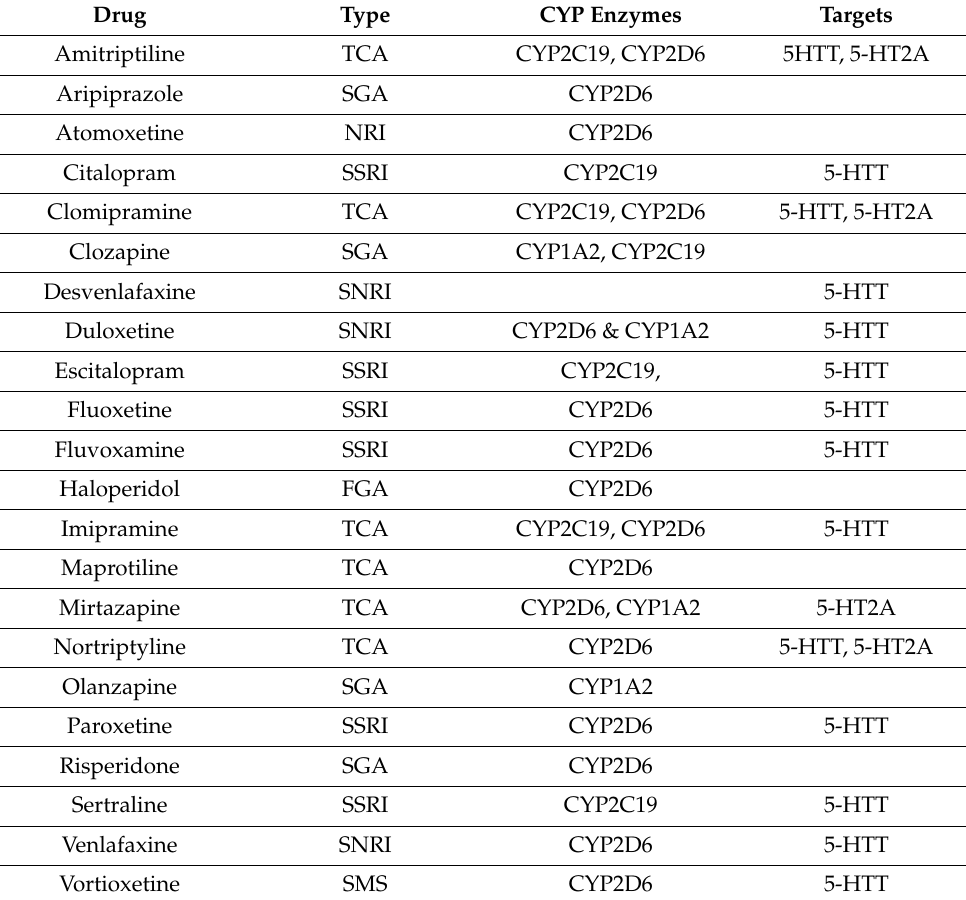
Table 3. List of drugs and the relevant metabolic enzymes and targets investigated.